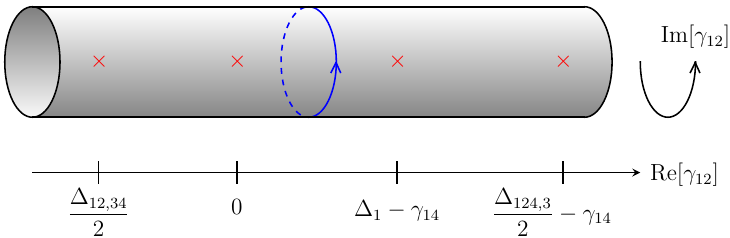
Figure 4 . Integration contour for (cid:13) 12 for computing the position space 4-point contact amplitude starting from its Mellin representation eq. (3.5). The circumference of the cylinder is (cid:25)